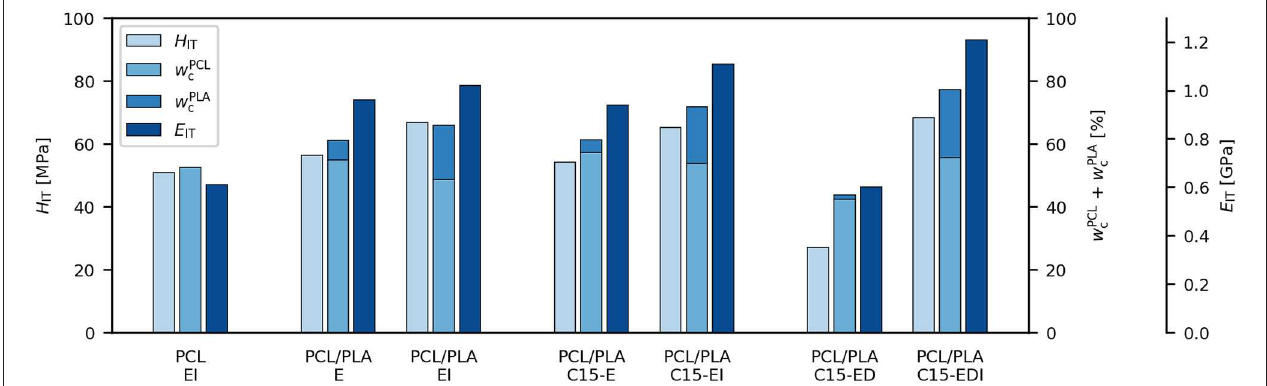
FIGURE 4 | Correlation between sum of crystallinities of PCL matrix and PLA particles ( w PCL c + w PLA c ), indentation hardness ( H IT ) and indentation modulus ( E IT